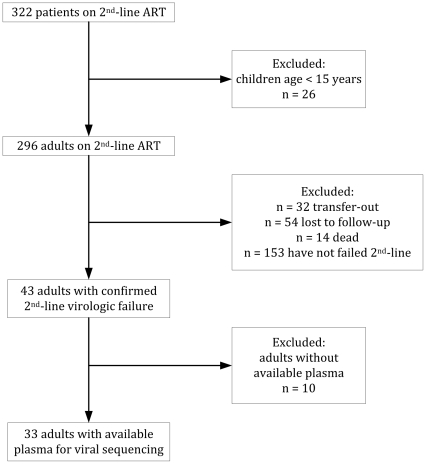
Study flow diagram.